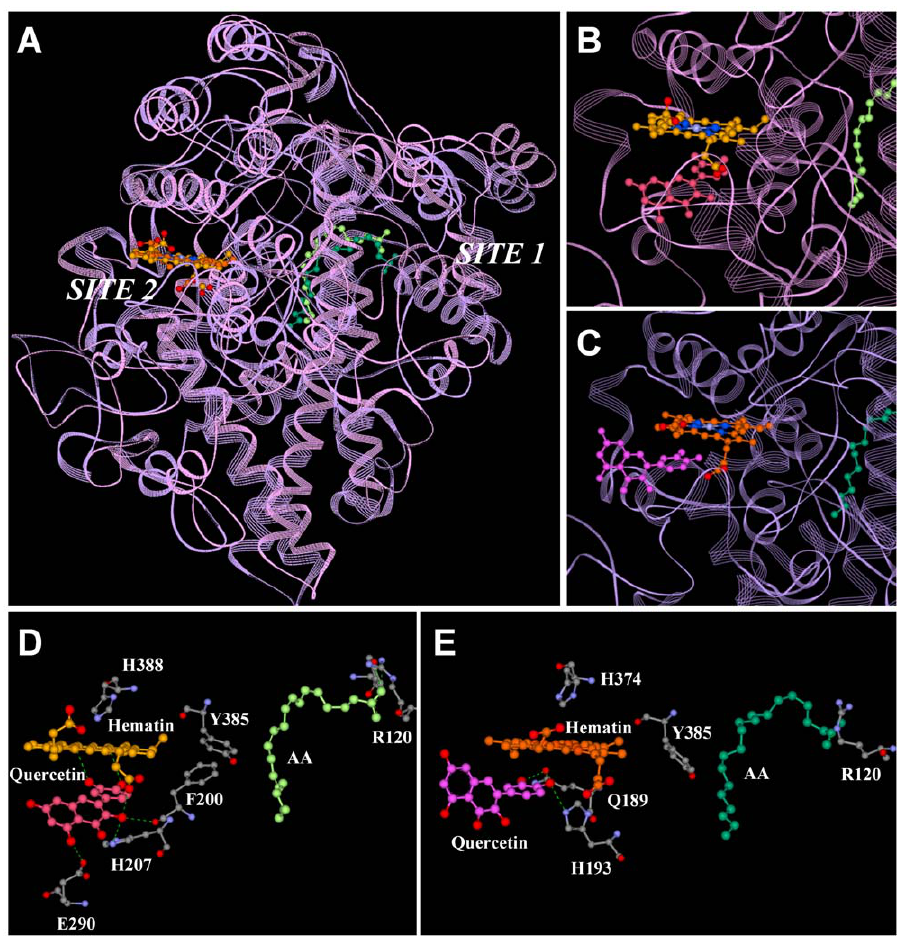
Figure 4. Identification of the binding sites for COX I and II by molecular docking approach. A . The superimposed structures of COX I and II in complex with hematin and AA. The white labels indicate the two potential binding sites for quercetin as identified by the Active-Site-Search function in InsightII . B . Docking results for quercetin in S ITE -2 of COX I. C . Docking results for quercetin in S ITE -2 of COX II. D . Enlarged view of the interaction of quercetin with hematin and key amino acid residues in the peroxidase active sites of COX I. E . Enlarged view of the interaction of quercetin with hematin and key amino acid residues in the peroxidase active site of COX II. The protein structure was shown in the ribbon format in A , B and C . COX I was colored in pink and COX II in purple. AA was colored in light green for COX I and dark green for COX II. Quercetin was colored in light red for COX I and magenta for COX II. Carbon atoms in hematin were colored in yellow for COX I and orange for COX II whereas nitrogen atoms were colored in blue, oxygen atoms in red, and magnesium in silver. The green dashes represent the hydrogen bonds. Hematin, AA, key amino acid residues, and quercetin are shown in the ball and stick format. For amino acid residues, oxygen atoms are shown in red, carbon atoms in gray, and nitrogen atoms in blue. Hydrogens are omitted in these molecules.